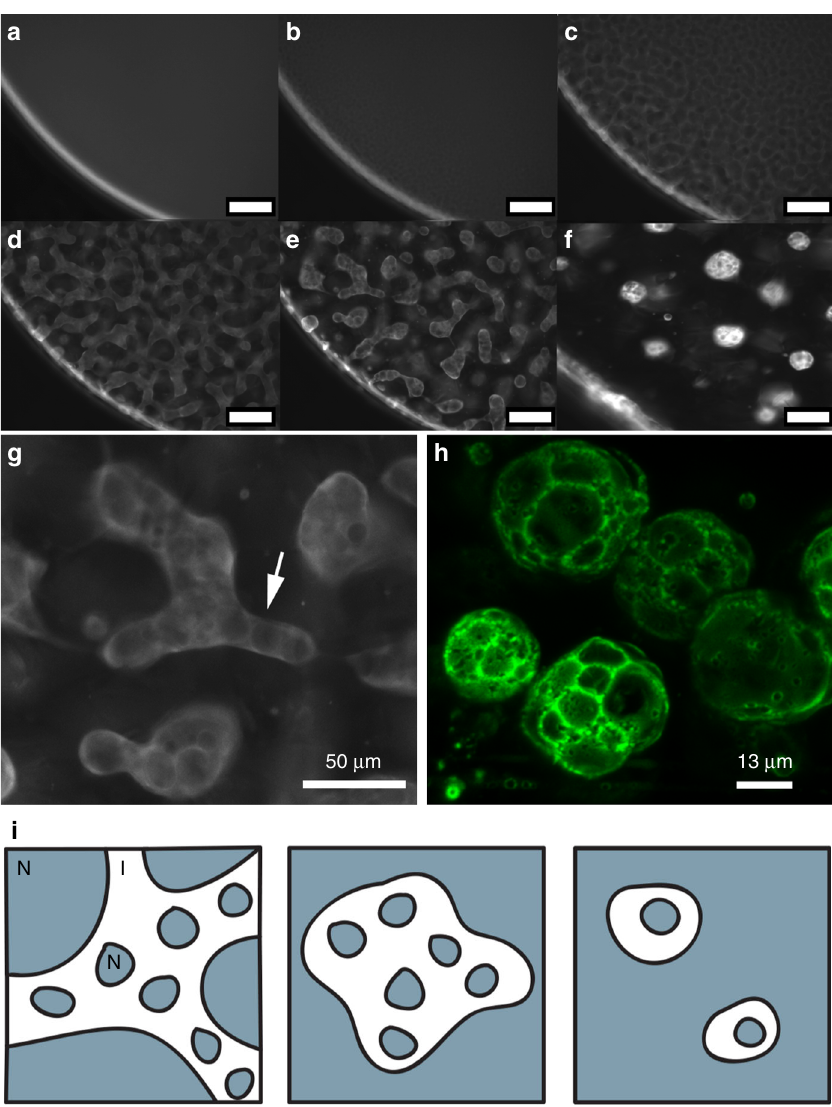
Fig. 5 Understanding the mechanism for structure differentiation. a – f Series of snapshots taken from a fl uorescence microscope movie demonstrating the foam formation process in a droplet of liquid crystal with initially well-dispersed quantum dots (QDs). In these images, QD-rich areas appear light and QD- poor areas appear dark. The curved white line in these images is the edge of the droplet, with liquid crystal on the right of this curve. Scale bars for a – f are 100 µ m. g A zoomed-in view from e with the arrow indicating inner nematic domain nucleation. h A confocal microscope image of several foam structures suspended in 5CB. Images taken from stack of 40 images, Max projected and false colored using Fiji software. i schematics illustrating the role of secondary nucleation on fi nal structure showing the particle-rich isotropic phase as white and the nematic phase as gray: left: secondary domains nucleate early on while the isotropic domain is still connected, center: secondary domains nucleate after isotropic domains have separated. and right: secondary domains nucleate late, when isotropic domains have already reached a small